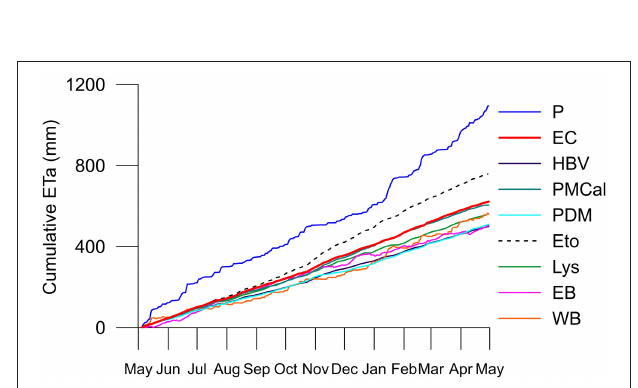
FIGURE 4 | Cumulative daily actual evapotranspiration measured by the eddy-covariance (EC) and lysimeters (Lys) and estimated by the PDM and HBV-light hydrological models, the water balance (WB) and energy balance (EB) methods, the calibrated evapotranspiration equation (PMCal), and the potential evapotranspiration (ETo). Cumulative precipitation (P) is also